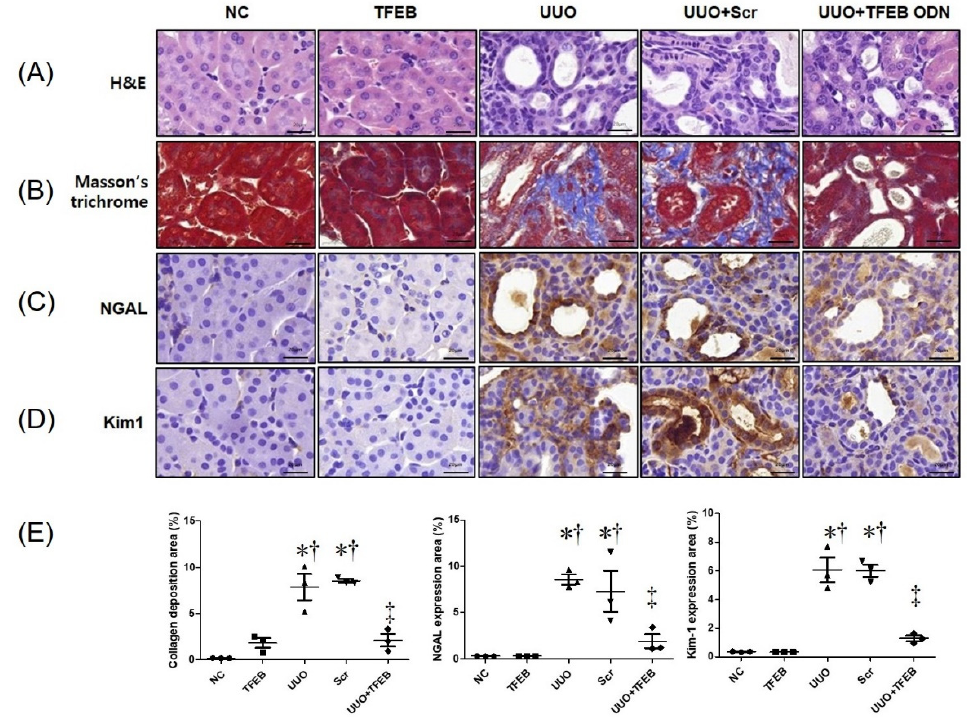
Figure 1. TFEB decoy ODN attenuated morphological changes and tubular injury in UUO-induced renal fibrosis in mice. ( A ) Paraffin-embedded kidney section stained with hematoxylin and eosin (H&E); ( B ) Masson’s trichrome staining; immunohistochemical staining showing the protein expression of ( C ) NGAL and ( D ) Kim-1 protein; ( E ) quantification of collagen, NGAL, and Kim-1 expressions. Quantitative analysis of collagen or protein expression area of each group ( n = 3; 400 × magnification). Original scale bar = 20 µ m. The results are expressed as mean ± SE of three independent experiments. * p < 0.05 vs. the NC group. † p < 0.05 vs. the TFEB group. ‡ p < 0.05 vs. the UUO or Scr group. NC, normal control group; TFEB, TFEB decoy injection in the normal control group; UUO, UUO surgery group; Scr, scramble ODN injection in the UUO surgery group; UUO + TFEB, TFEB decoy ODN injection in the UUO surgery group; UUO, unilateral ureteral obstruction; decoy ODNs, decoy oligonucleotides; TFEB, Transcription factor EB; Scr, scrambled.